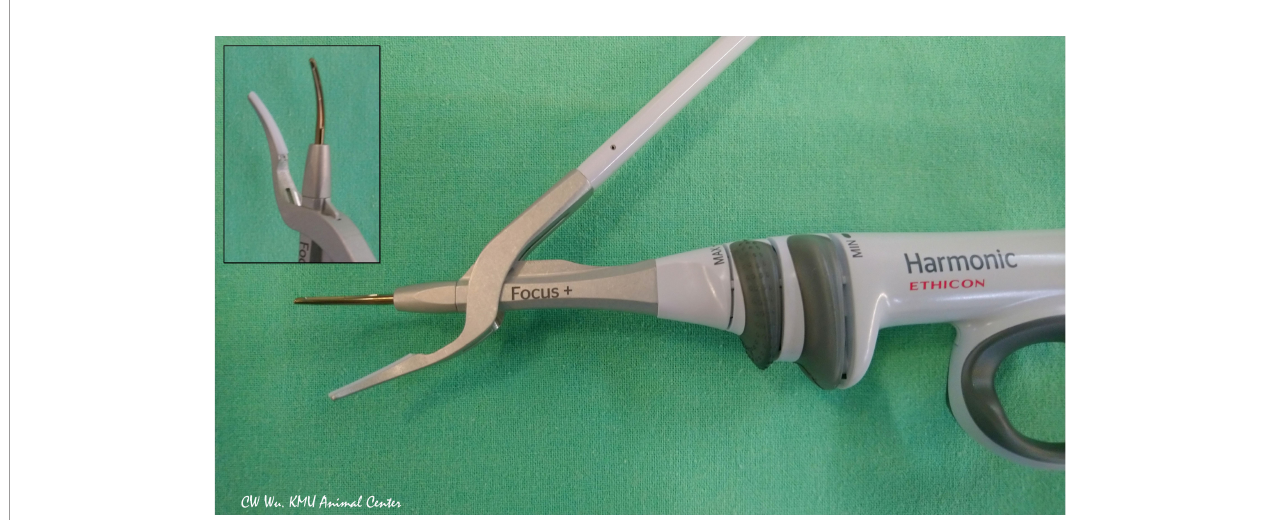
FIGURE 4 | Ultrasonic energy based device. Harmonic Focus+ (HF+) (Ethicon, Johnson and Johnson, Cincinnati, OH, USA). The HF+ is widely used in open thyroid surgery. Its curved and tapered tip has bare blades on one side and a non-active tissue pad on the opposite